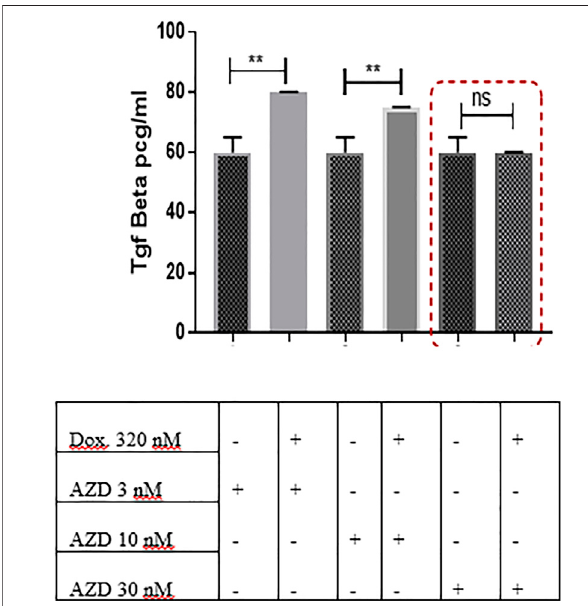
FIGURE 6 | AZD5069 prevents doxorubicin-mediated TGF- β upregulation in 3D culture. TGF- β concentration levels were obtained from ELISA and were compared in different treatment conditions. Data are expressedasTGF- β concentration.Dox:doxorubicin;AZD:AZD5069. p values:TheTGF- β concentrationlevelofeachcombined treatmentgroupwas compared to the concentration of the corresponding AZD dose alone using unpaired Student ’ s t-test.